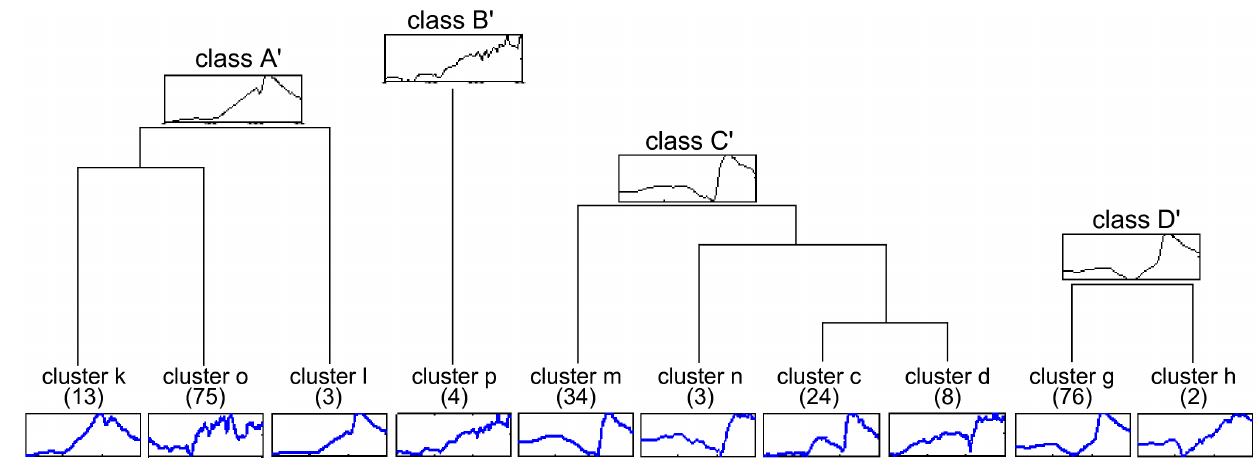
Figure 3. Dendrogram representation for hierarchical clustering of clusters.